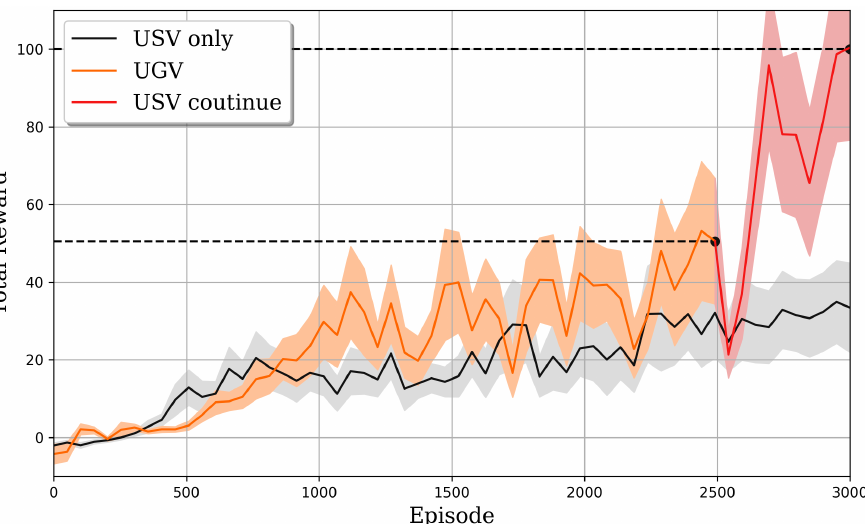
Figure 9. Total reward across training episodes for different training strategies. The black curve shows the reward of a USV being trained for 3000 episodes. The orange and red curve shows the reward of hybrid training. The orange curve is a UGV being trained for 2500 episodes and then the red curve is a USV transferring the policy from the UGV and keeping training for 500 more episodes. Once the DQN network reaches a reward of approximately 50, the DRL agent can finish the square course with eight waypoints two to three times without collision. The trajectory of finishing one loop is visualized in Figure 10. This model is then loaded on a USV and is trained for 500 episodes in simulation. Then the final reward reaches 100. The total training time is 72 h. Compared to the cross-domain training, the agent only trained on a USV for 3000 can only receive a reward of around 30 with a total training time of more than 100 h.